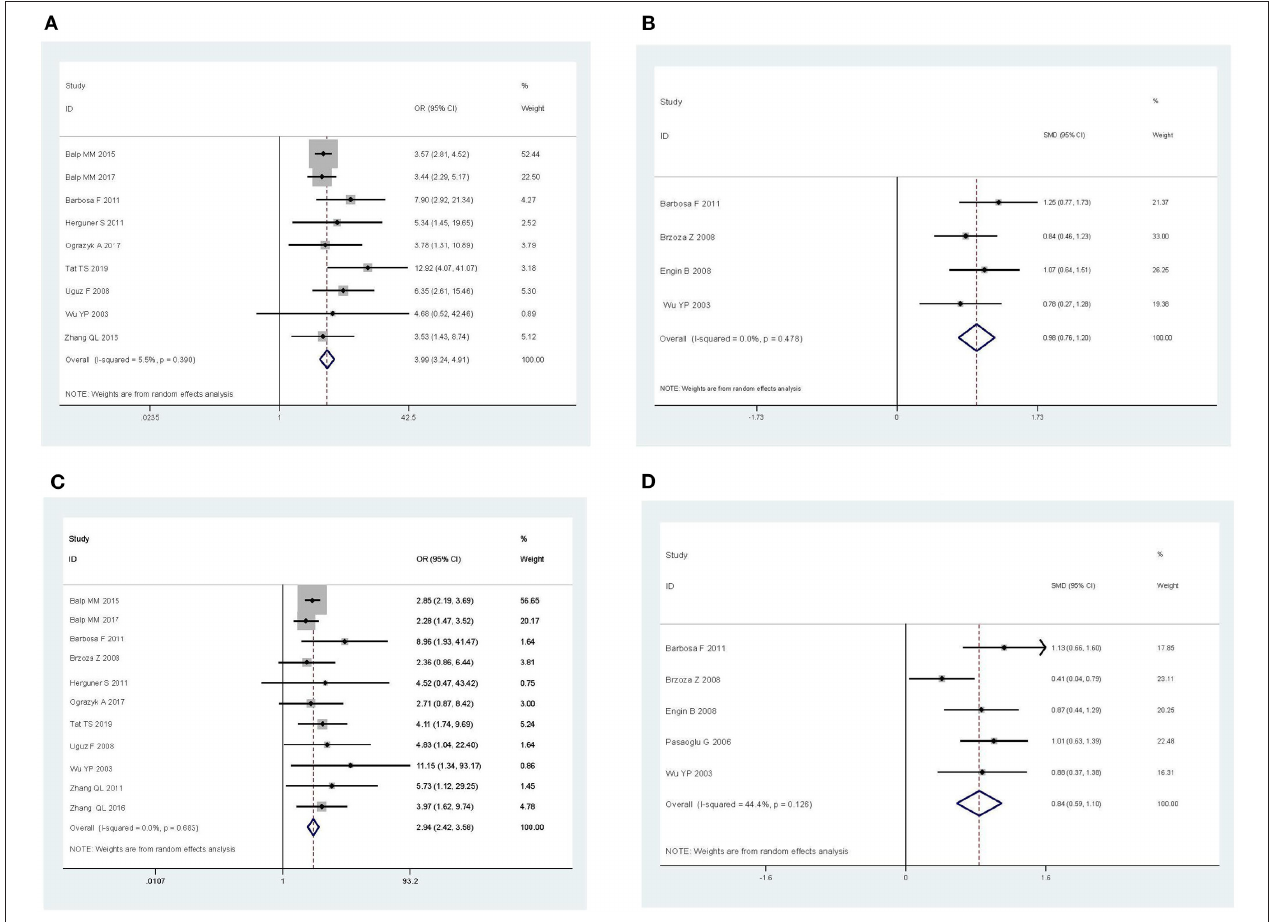
FIGURE 2 | Pooled estimates of the associations of chronic urticaria with symptoms of anxiety and depression. (A) Anxiety, in terms of odds ratio. (B) Anxiety, in terms of standardized mean difference. (C) Depression, in terms of odds ratio. (D) Depression, in terms of standardized mean